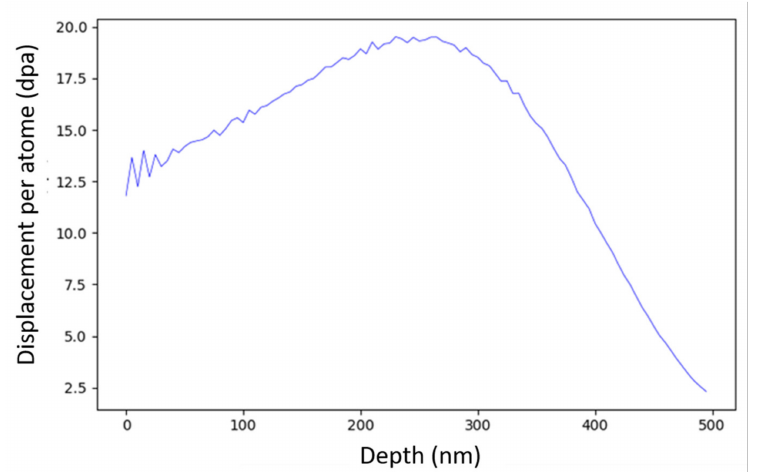
Figure 1. Depth profile of irradiation damages (displacement per atom) in Fe calculated by Iradina [14] using 4000 keV-Au 2+ ions with a fluence of 4.0 × 10 15 ions · cm − 2